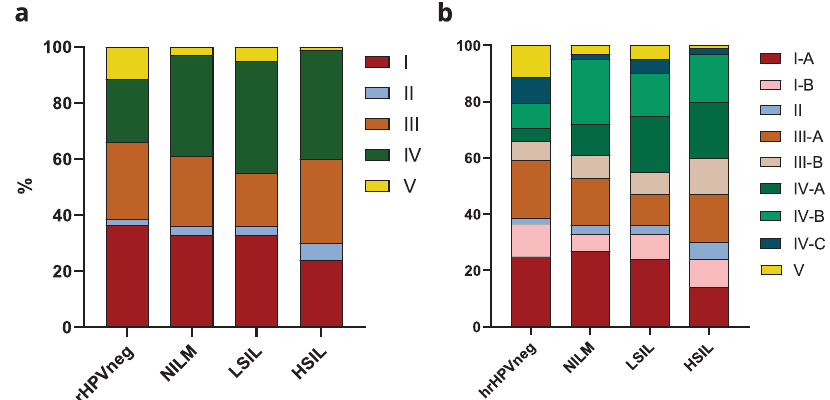
Fig. 5 Distribution of microbial communities in hrHPV-associated cervical disease. a The CVM in hrHPV-negative women and hrHPV- positive women with no cervical lesions (NILM), low-grade cervical lesions (LSIL), and high-grade cervical lesions (HSIL) illustrate the microbial dynamics occurring upon hrHPV infection and disease progression according to the classical fi ve CSTs. These dynamics re fl ect the well- described decrease in CST I and increase in CST IV. There is also a signi fi cant decrease in CST V. Analysis of the same cohort considering the subdivision of CSTs shows the reduction of CST I observed in ( a ) from hrHPV-negative to HSIL is associated with CST I-A ( b ) while CST III-A seems stable in all stages. Alternatively, there is a slight increase in the proportion of women with CST II and III-B in HSIL compared to NILM ( b ). CST IV-A likely occurs upon hrHPV infection ( b ), and its incidence increases upon disease progression (LSIL and HSIL). hrHPVneg: hrHPV- negative, n = 44; NILM , n = 100; LSIL, n = 100; HSIL, n = 100. Source data are provided as a Source data fi